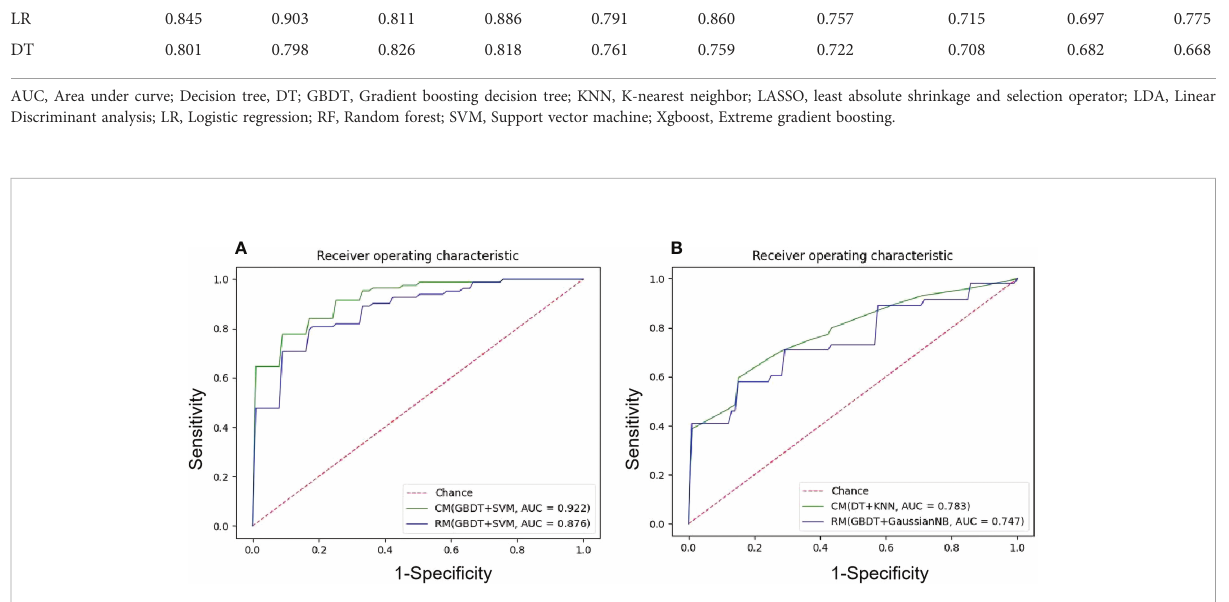
Table 6. LASSO as a feature selection method did not select any clinical information and subjective CT fi ndings for analysis